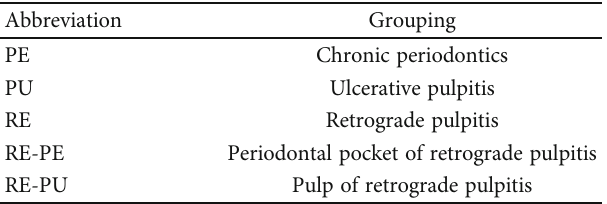
Table 1: The summary of grouping